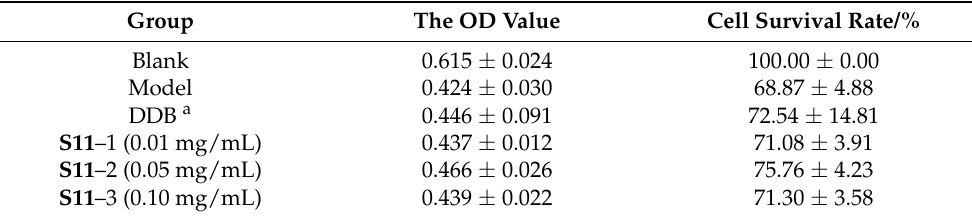
Table 2. The protective activity of different concentrations of sample S11 against CCl 4 -induced liver injury ( x ± s , n =